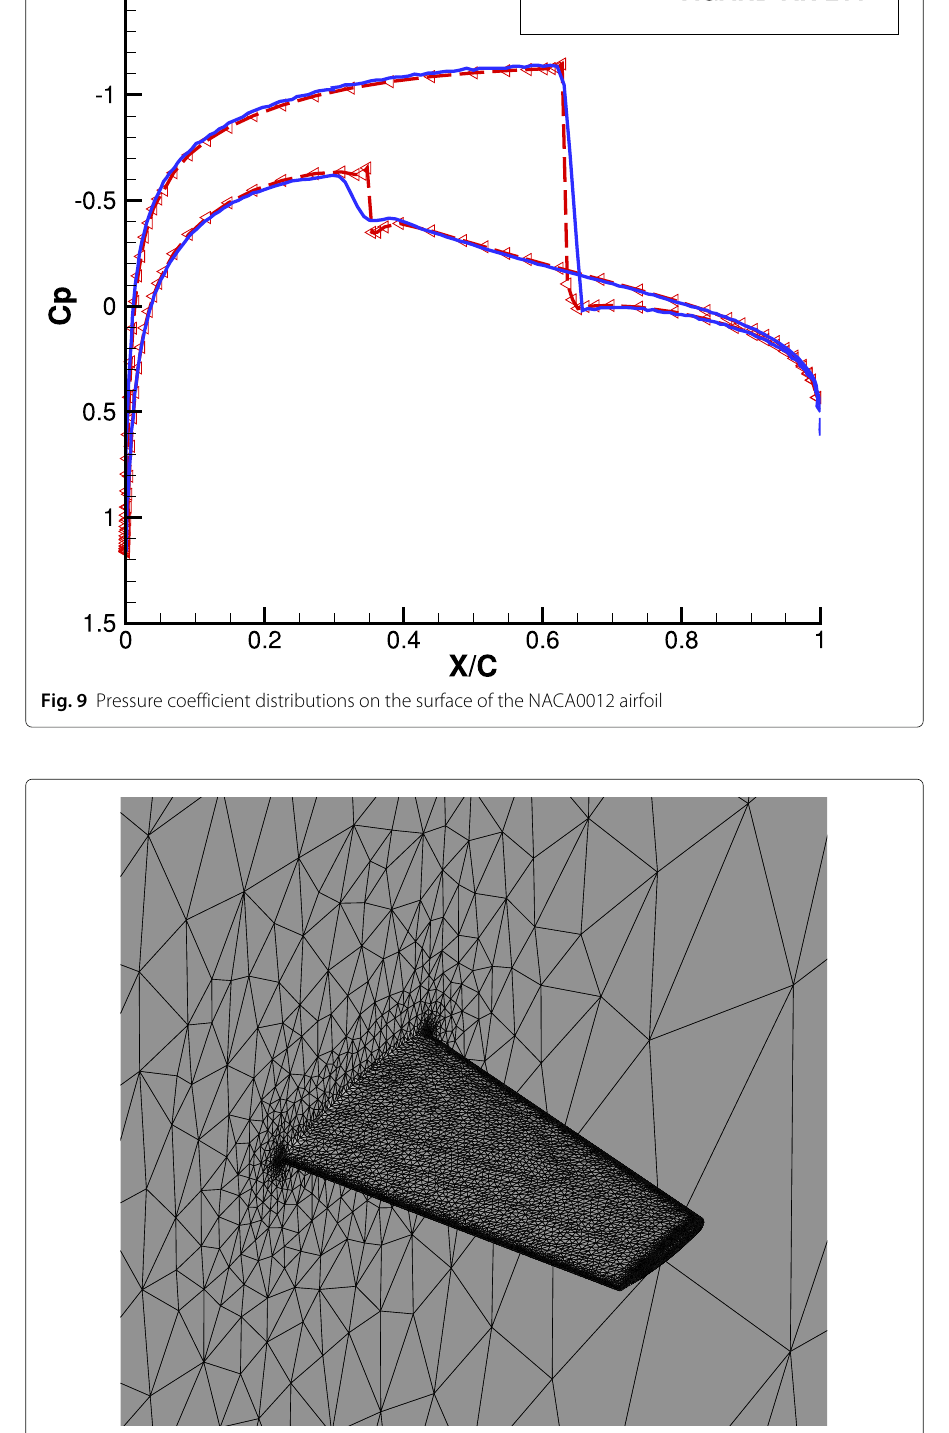
Fig. 10 Mesh for M6 wing test case in the 3D Euler